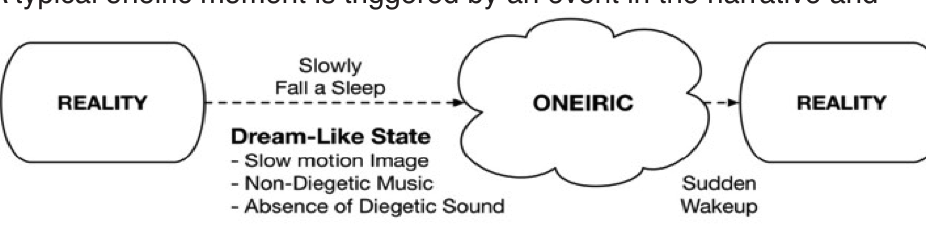
Figure 5: Transitioning to, and from, an oneiric moment.